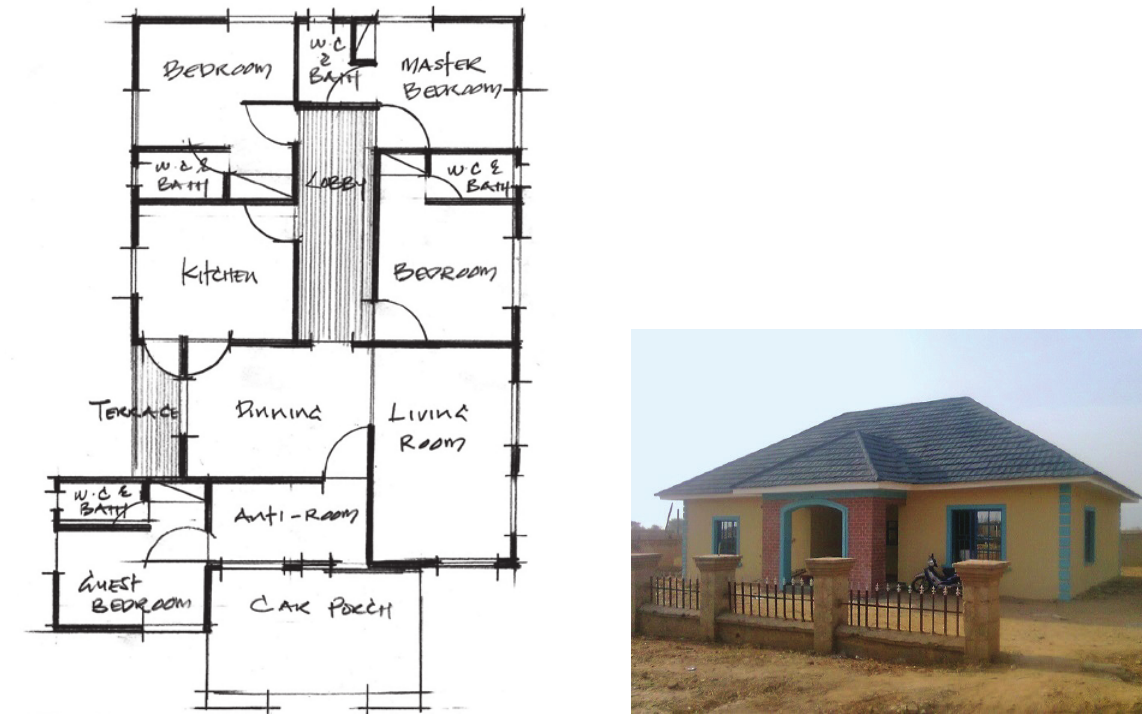
Fig. 9. Floor plan and picture of a detached bungalow house Source: Ekhaese